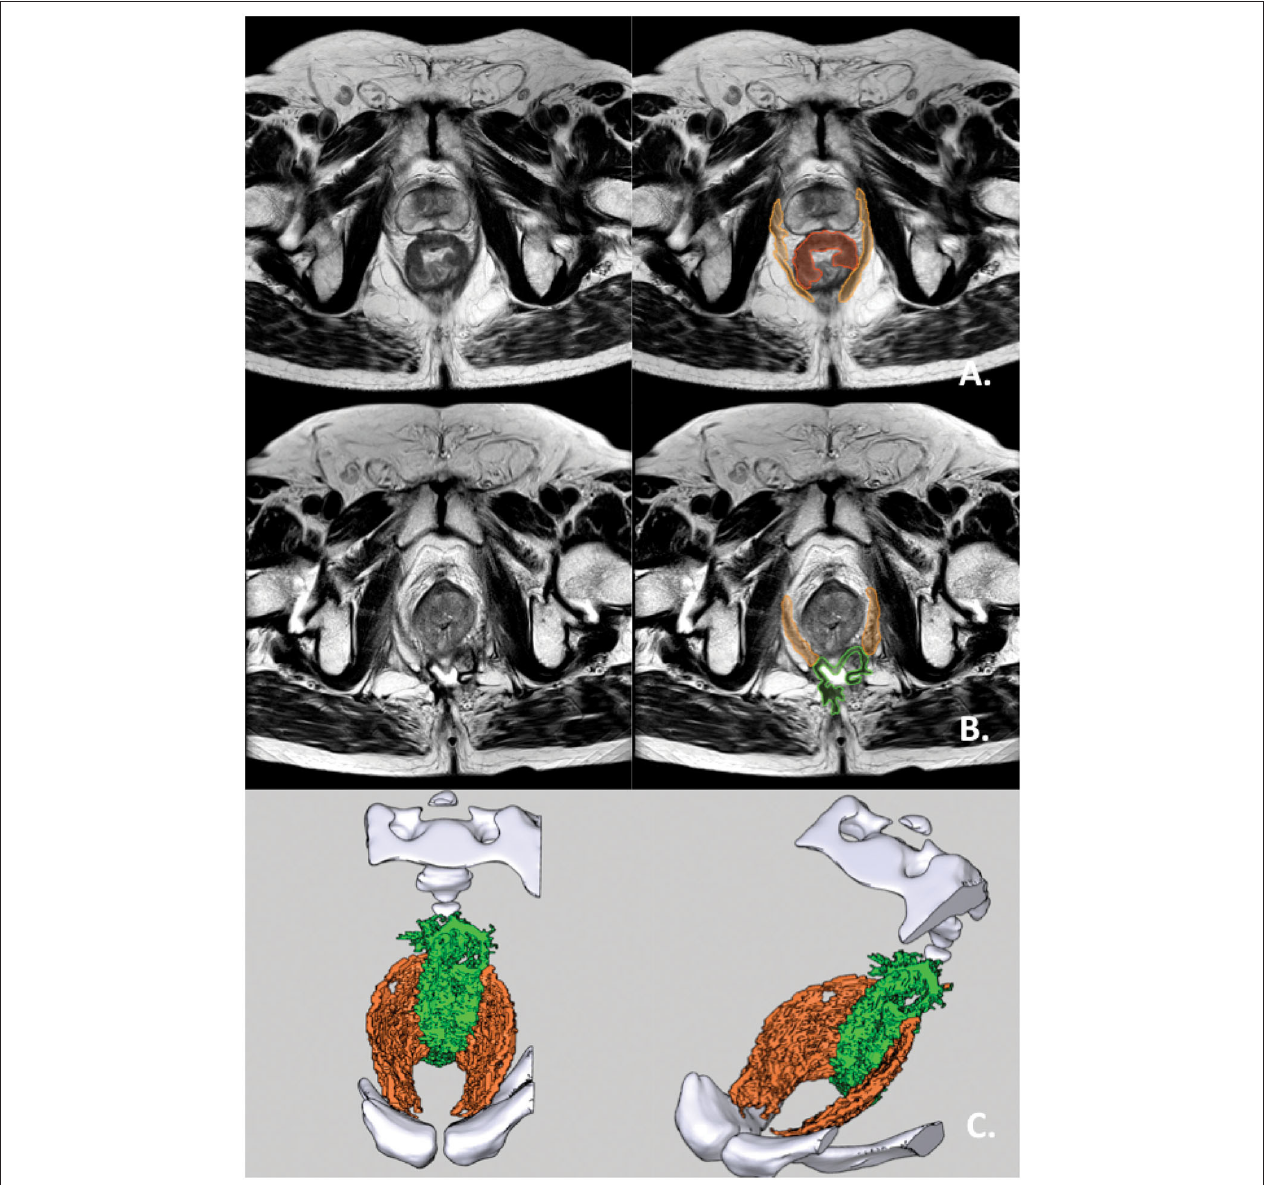
FIGURE 5 | ELAPE with RPD in both posterior quadrants. (A) Preoperative axial T2-weighted MRI of a rectal cancer patient with an mrT3 tumor with invasive growth from 9 o’clock to 2 o’clock. The pelvic diaphragm is hatched in orange. The tumor is hatched in red. (B) Postoperative axial T2-weighted MRI of the same patient. RPD hatched in orange while supporting mesh hatched in green. (C) The pelvic diaphragm of the same patient, 3D-rendered and shown in superior and antero-lateral superior views. The rendering is made from the above postoperative MRI. The bony pelvis is rendered in white. RPD is rendered in orange. Supporting mesh is rendered in bright